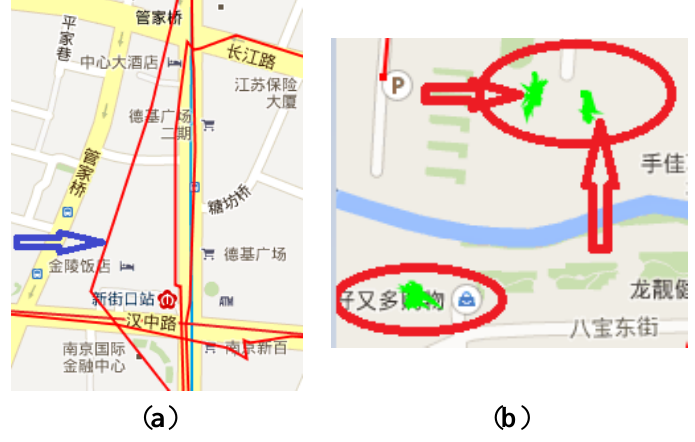
Figure 2. ( a ) flip trajectory example; ( b ) parking trajectory